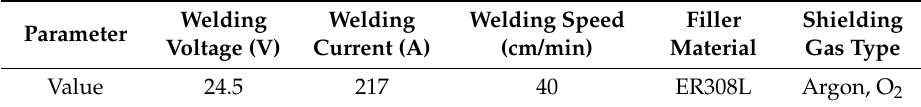
Table 2. Technical parameters of the MIG